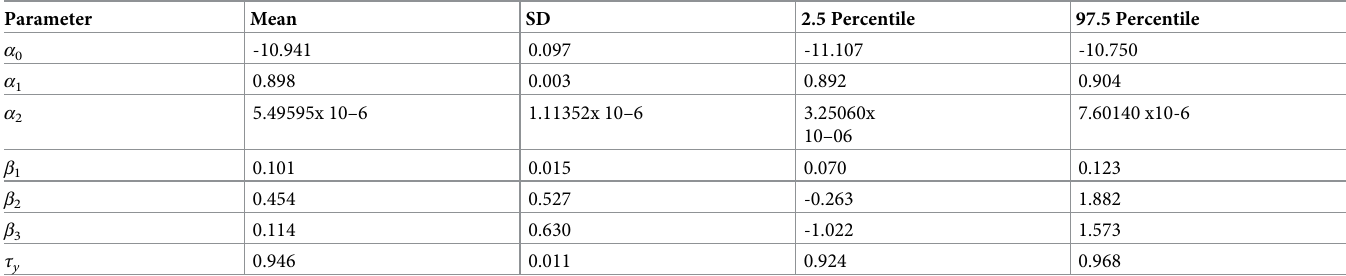
Table 5. 3D smoothed data: Parameter estimates for model